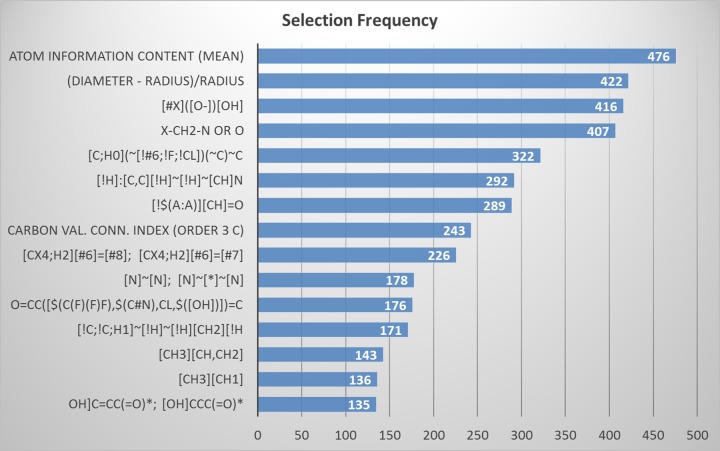
Top 15 features selected by SVM model.The features are ranked by selection frequency descending order, while frequencies are marked at the right side of the bar.